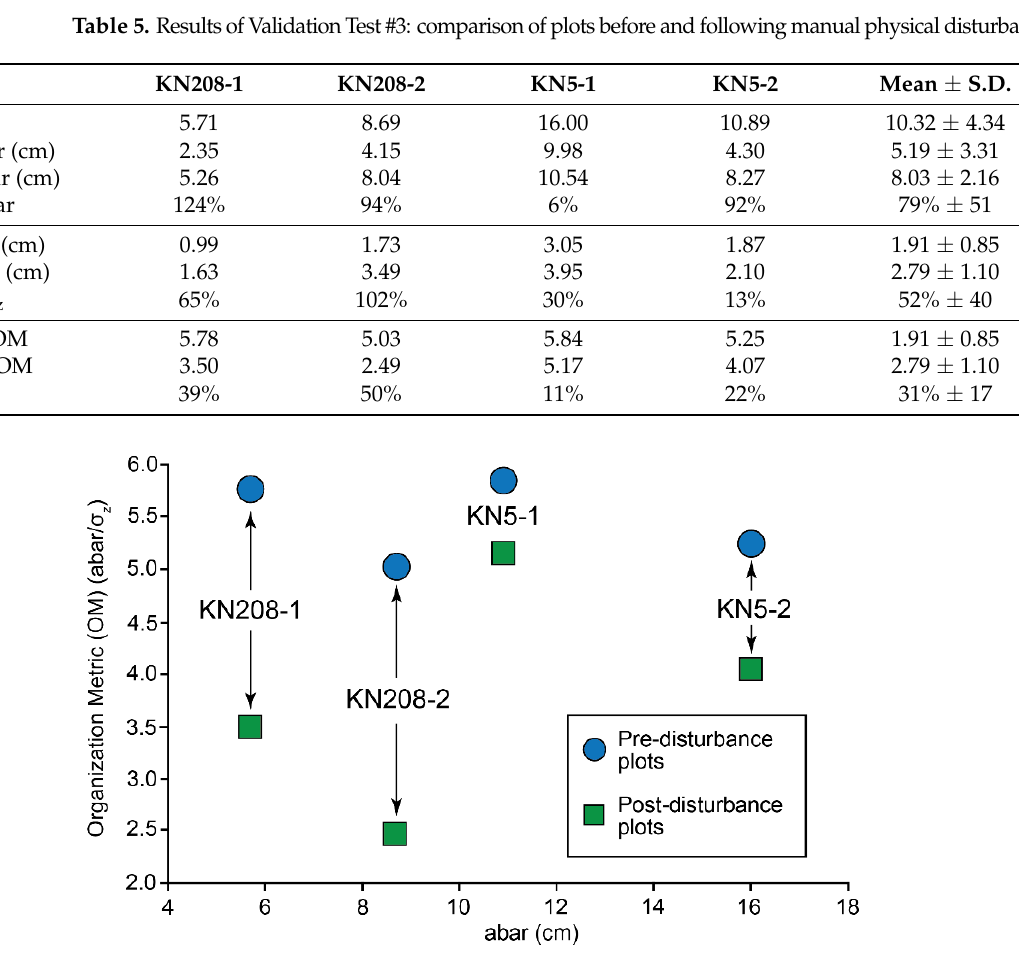
Figure 9. Results of Validation Test #3: comparison of plots before and following manual physical disturbance.